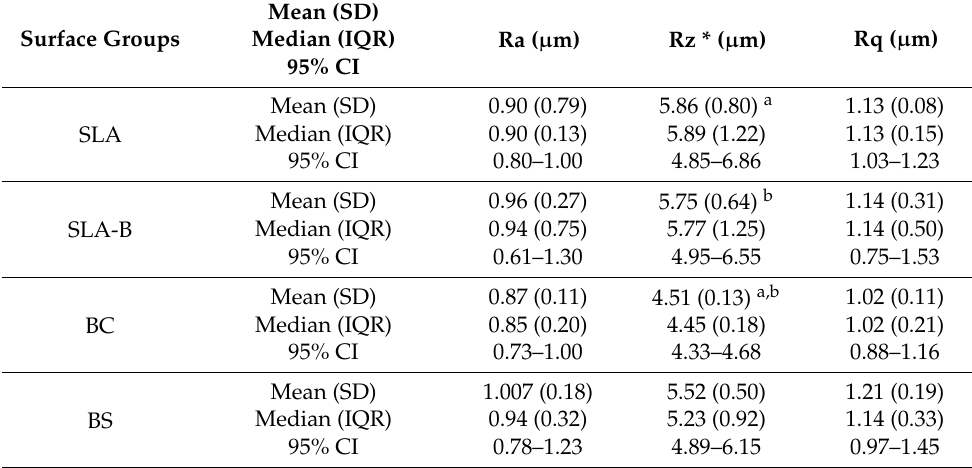
Figure 5. Box-and-whisker plots showing median and quartile values for the implant roughness values (Ra, Rz, and Rq). * represents outliers. Table 2. AFM measurements of the surface roughness parameters on the experimental disks .